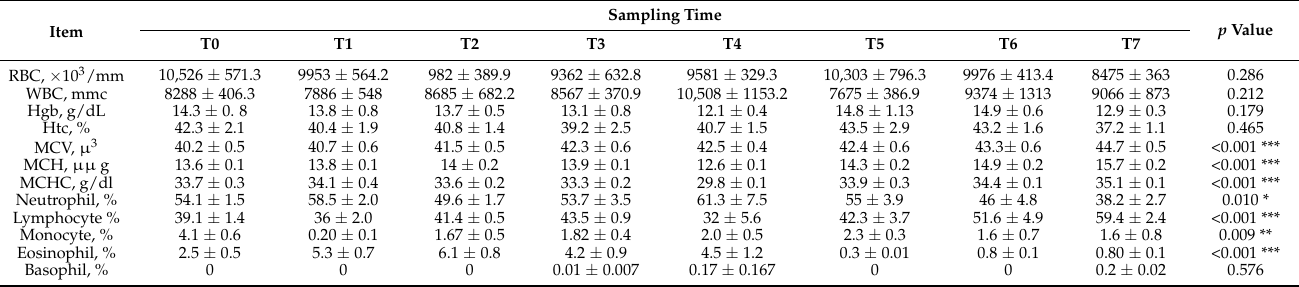
Table 2. Haematological parameters of trotter horses in relation to the training program. Sampling Time